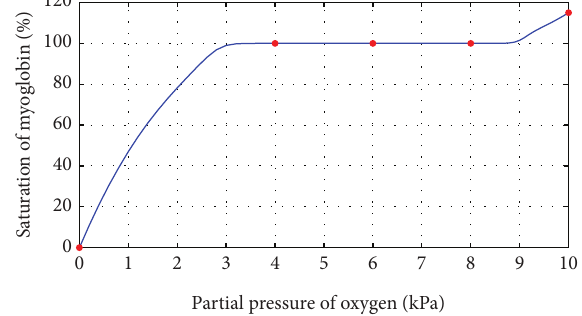
Figure 2: 𝐶 1 monotone rational trigonometric cubic function with = 2.6, 𝛿 = 0.4 . 𝛼 𝑖 𝑖